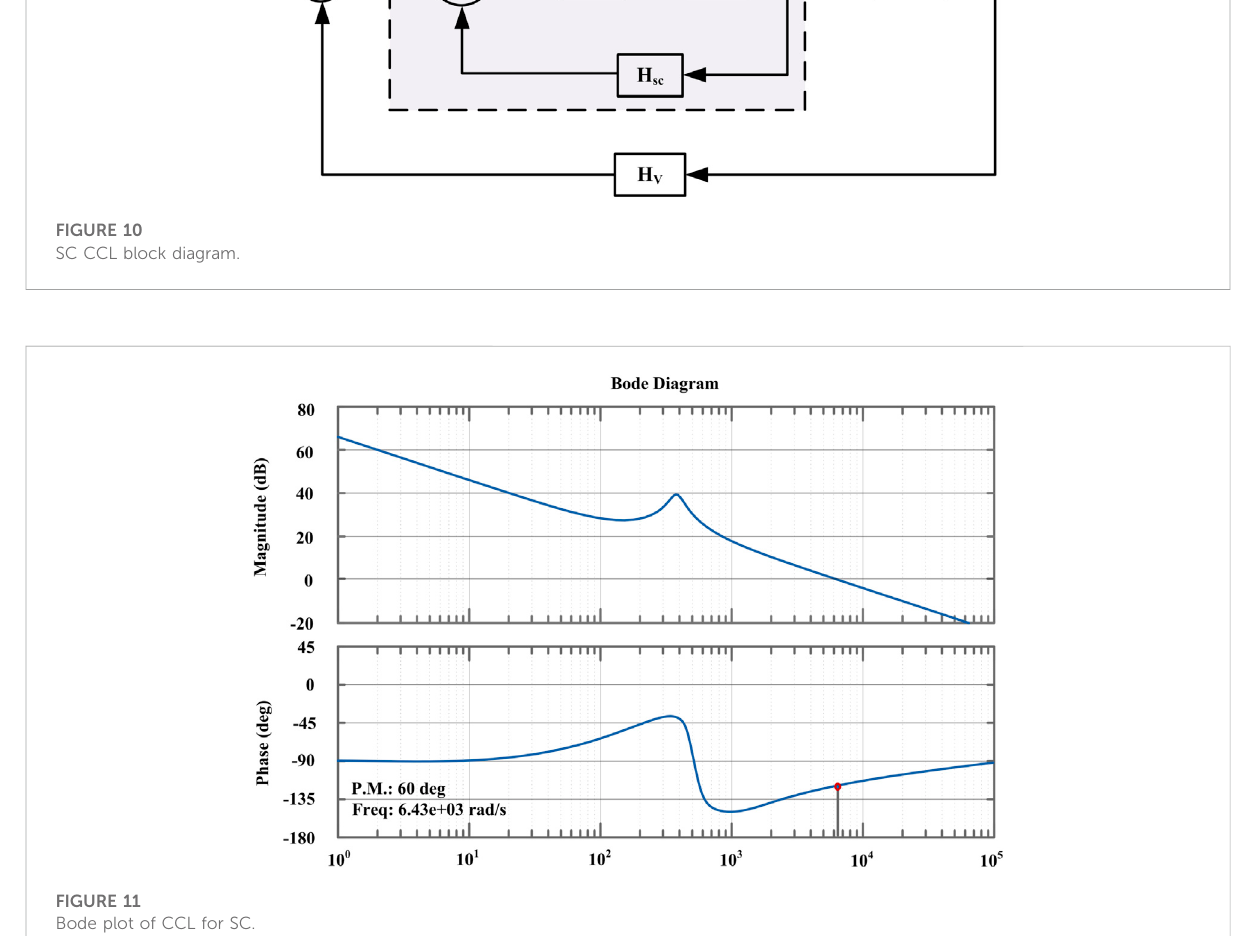
FIGURE 11 Bode plot of CCL for